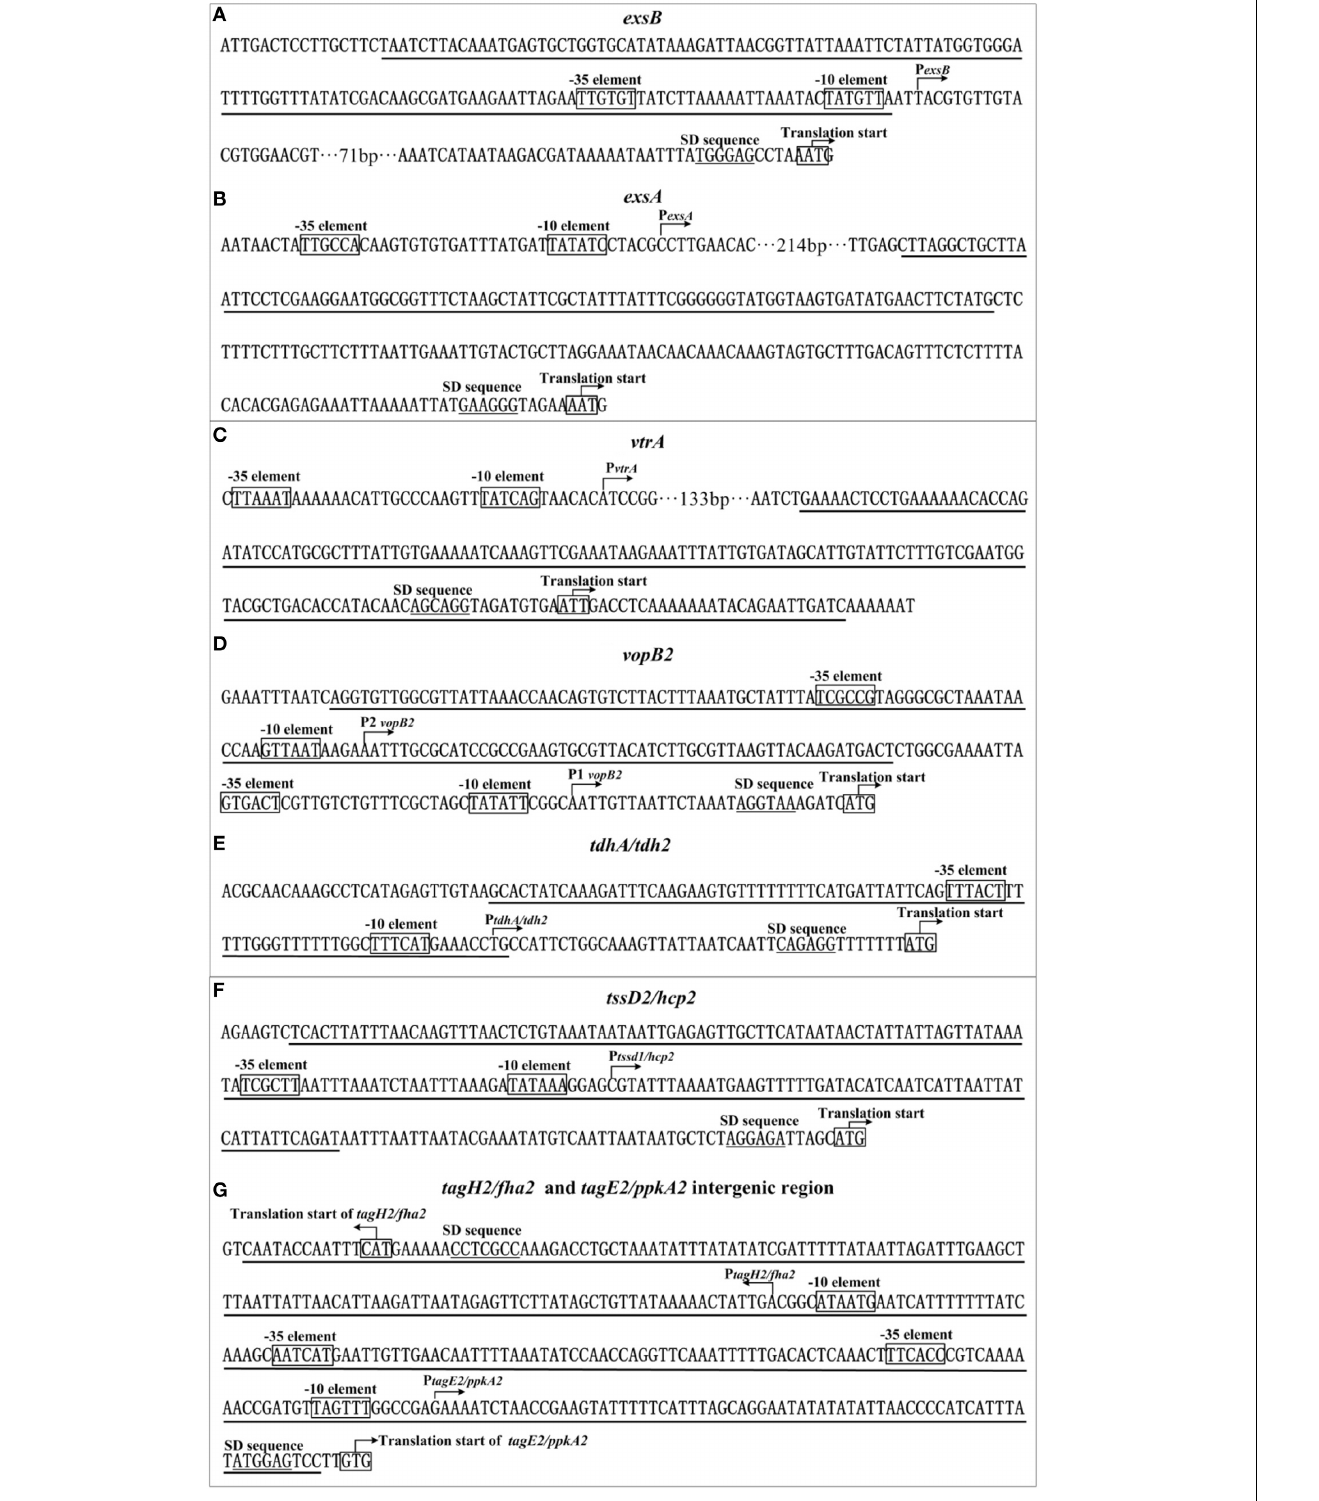
FIGURE 5 | Organization of promoter-proximal DNA regions. The promoter-proximal DNA regions of indicated genes ( A : exsB; B : exsA; C : vrtA; D : vopB2; E : tdh2; F : hcp2; G : tagH2, and tagE2 intergenic) were derived from RIMD 221063. Underlined nucleotide sequences are the H-NS sites.